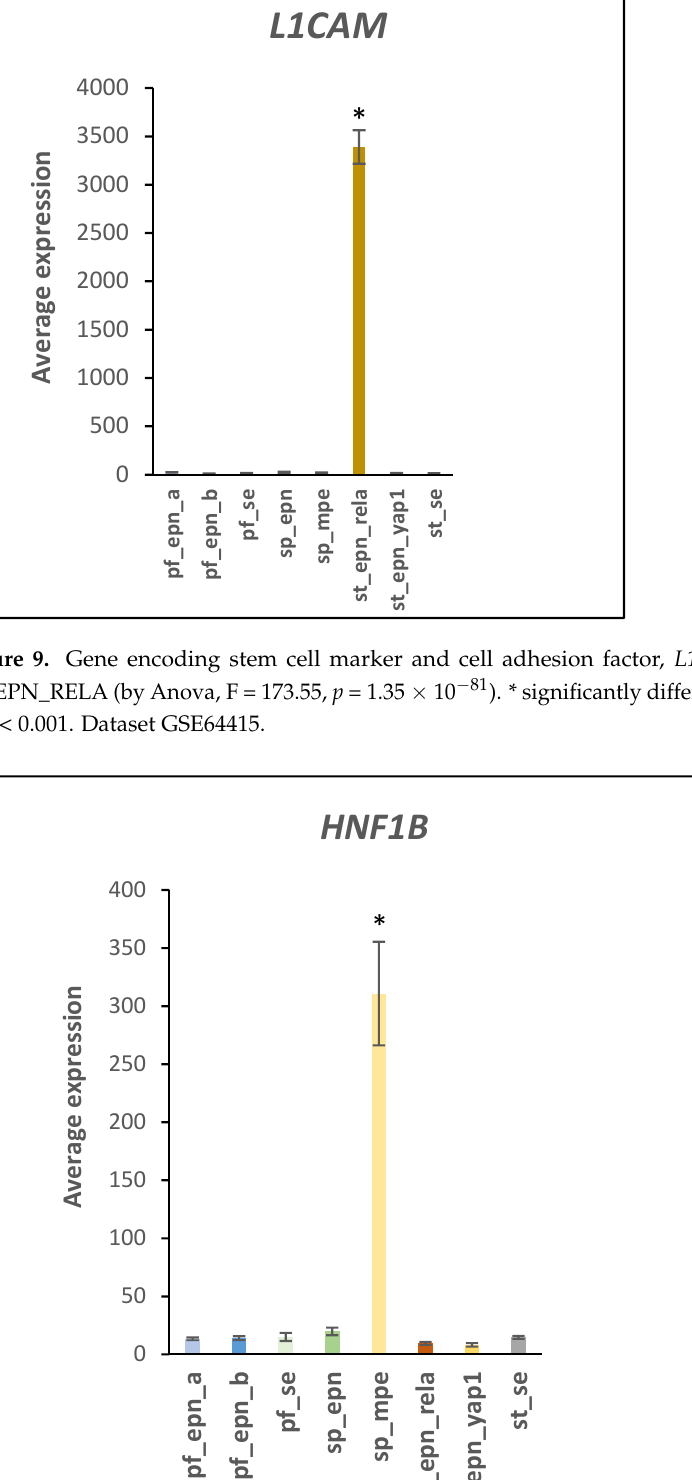
Figure 10. HNF1B expression in the SP-MPE subtype (by Anova, F = 151.68, p = 1.27 × 10 − 76 ) * by t -test significantly different from all other groups at p < 0.001. Dataset GSE64415.